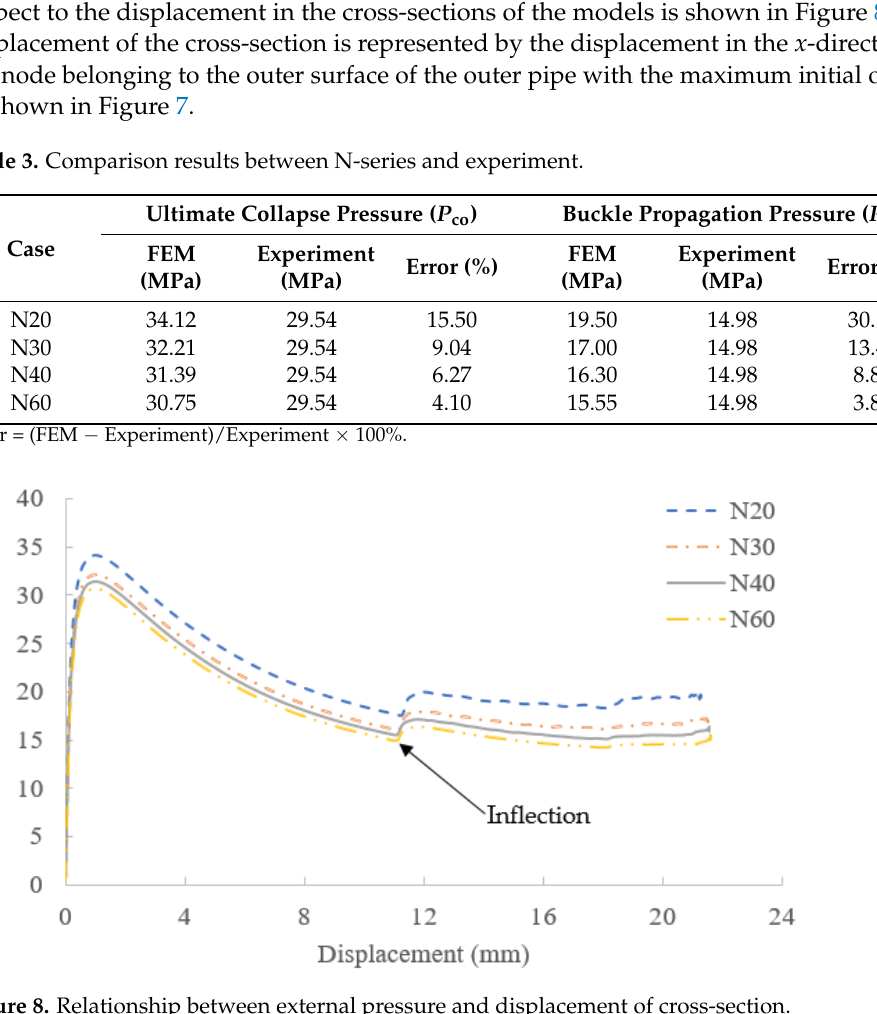
Figure 8. Relationship between external pressure and displacement of cross-section.